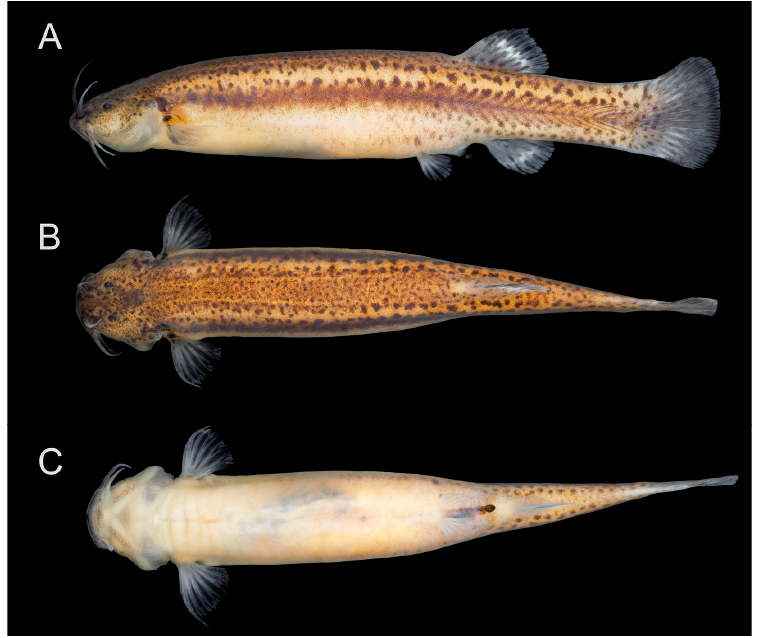
Figure 16. Trichomycterus (Paracambeva) septemradiatus . UFRJ 12940, Carmo do Rio Claro, 57.8 mm SL: ( A ) lateral, ( B ) dorsal, and ( C ) ventral views. 3.3. Key to Identi fi cation of Trichomycterine Species from MRGD